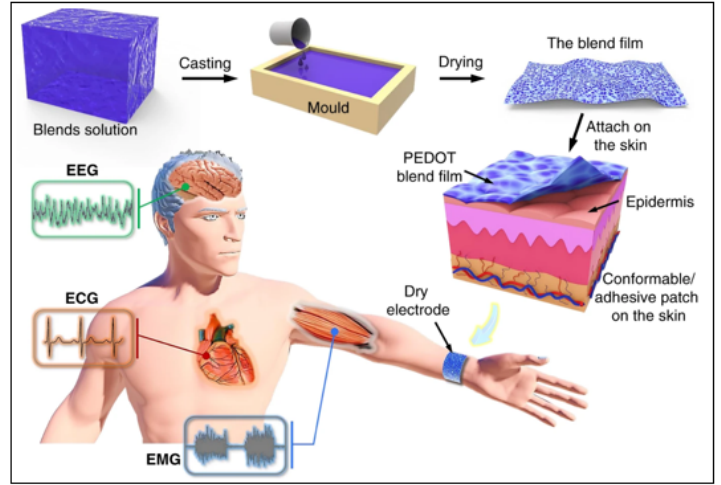
Figure 4. Fabrication and application of skin-surface electrode [58]. The resulting blend film can be used as an adhesive electrode on the skin for epidermal biopotential detections such as electrocardiography (ECG), electromyography (EMG), and electroencephalography (EEG). Reproduced under the terms of the CC-BY Creative Commons Attribution License, Copyright 2020 by the authors, published by Springer Nature.